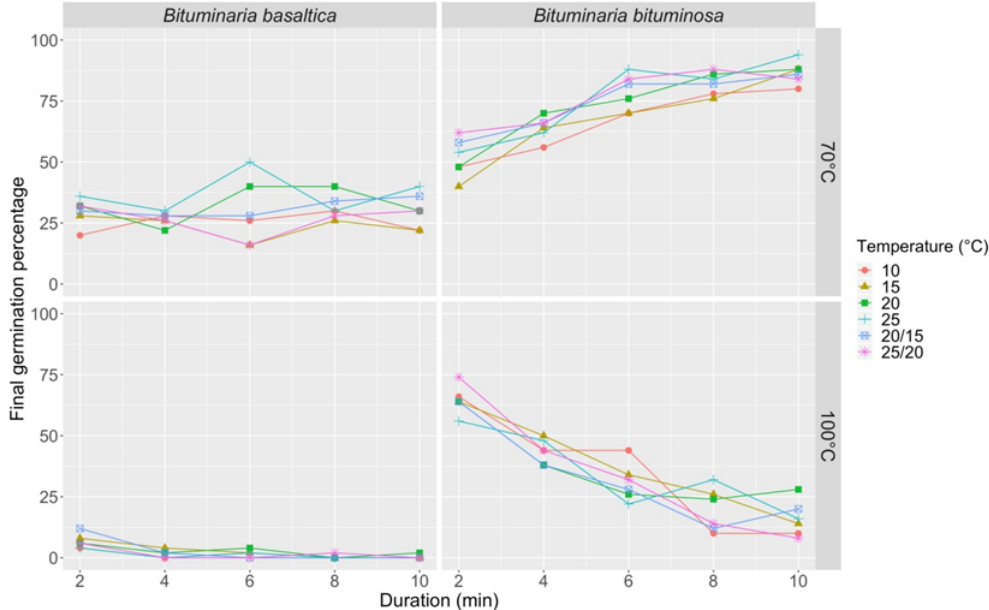
Figure 4. Final germination percentage at different incubation temperatures (10, 15, 20, 25, 20/15, 25/20 °C) in B. basaltica and B. bituminosa after different immersion times (2, 4, 6, 8, 10 min treatment duration) in hot constant water (70 and 100 °C).